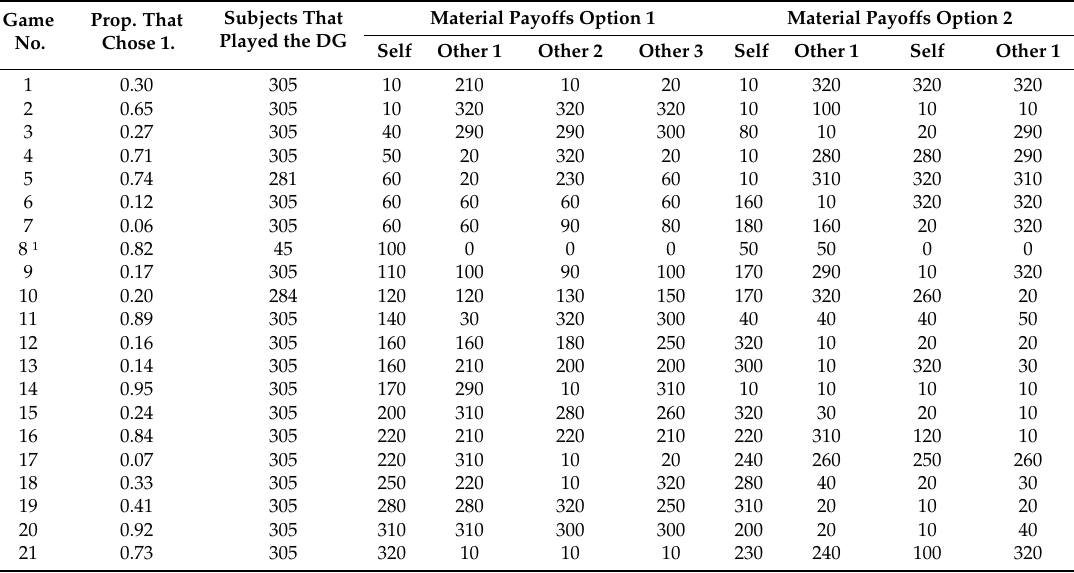
Table 4. Descriptive statistics and material payoffs for the four-player DGs in Experiment 2. Game Prop. That No. Chose